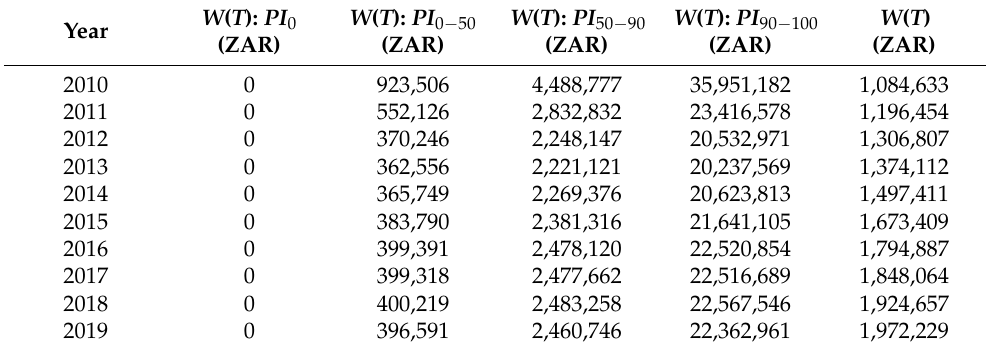
Table 2. Lifetime level of wealth W ( T